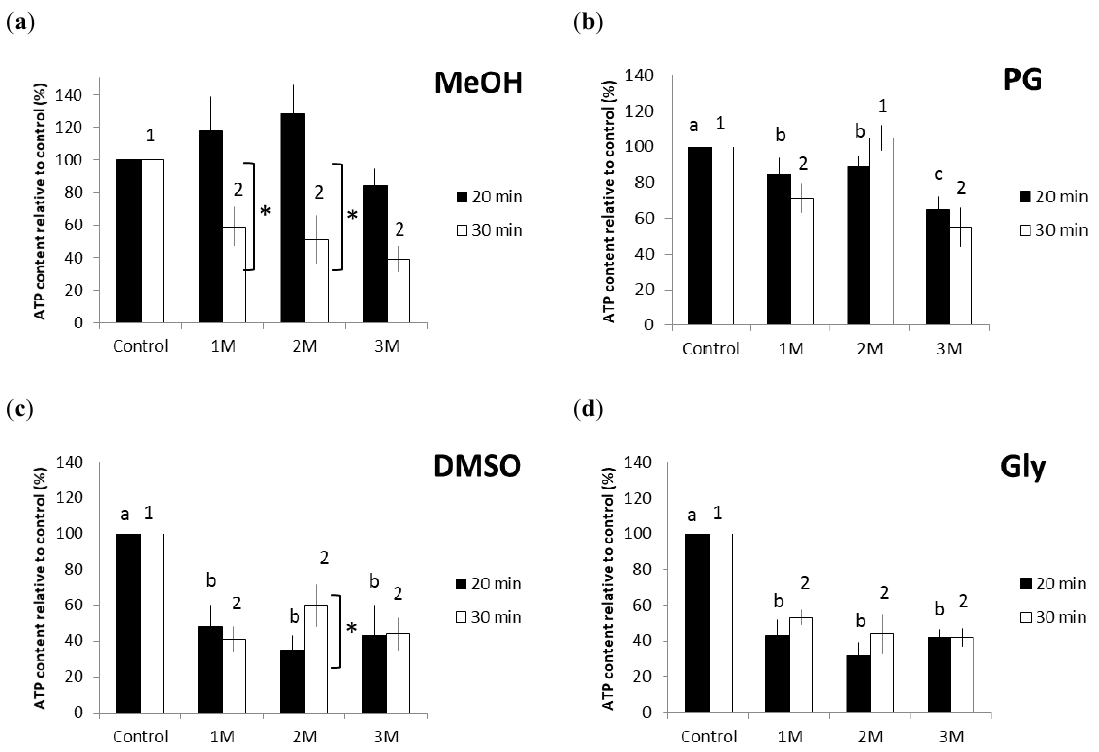
Figure 1. ATP content for thawed Breviolum that was cryopreserved with different CPAs: ( a ) MeOH, ( b ) PG, ( c ) DMSO, and ( d ) Gly. Breviolum was cryopreserved with 4 different types of CPAs at 3 varying concentrations (1, 2, and 3 M) and equilibrated for either 20 min or 30 min. The control group represents Breviolum not subjected to any treatment. Different letters and numbers represent a significant difference ( p < 0.05) in treatment groups of varying concentrations equilibrated for 20 and 30 min. Asterisks are marked for any significance difference observed under the same CPA concentrations but over different equilibration times. The error bar represents standard deviations.